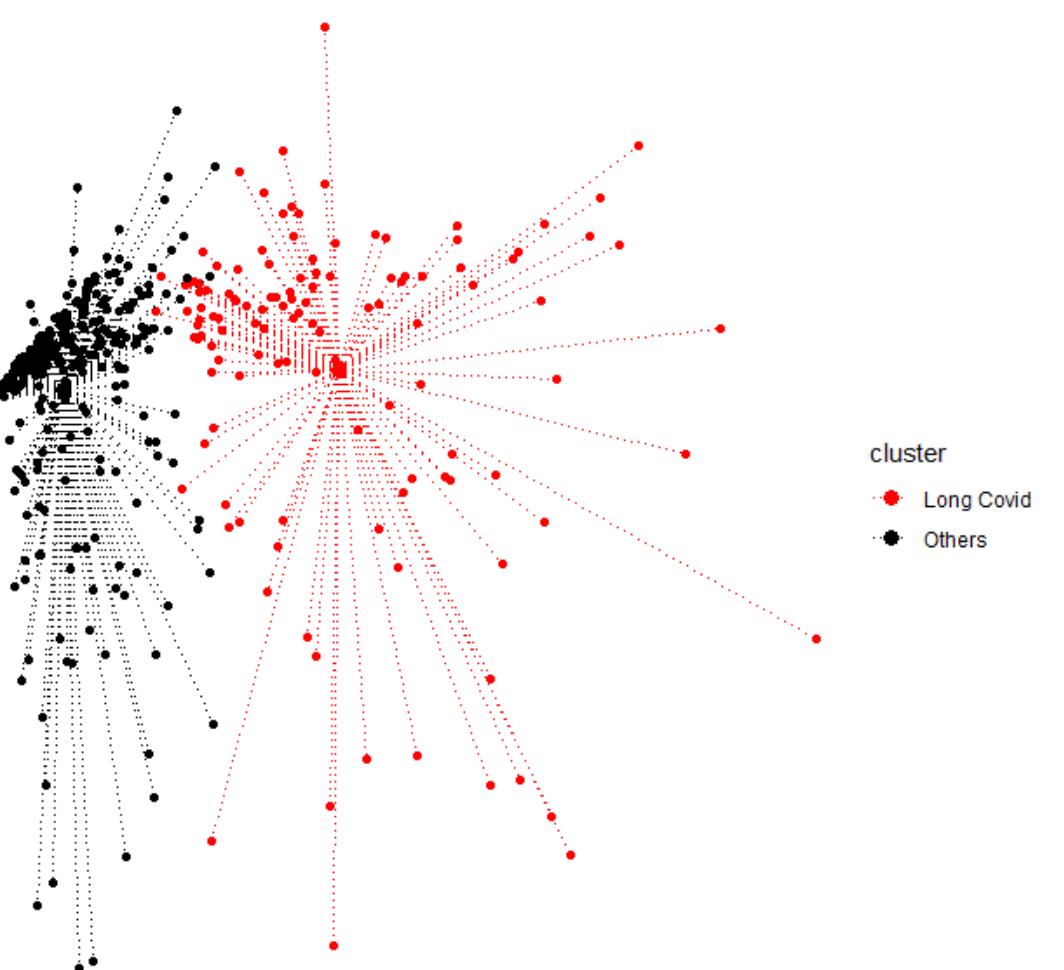
Figure 3. Two-dimensional representation of the clusters. The starplot centers represent the medoids.